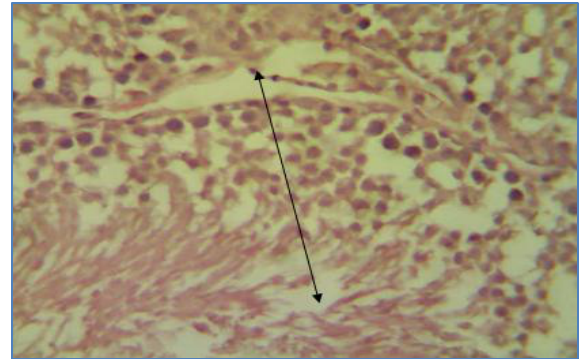
Figure, 10: Section in testis of control group shows normal structure of seminiferous tubules ( ), (H znd E stain 40X)